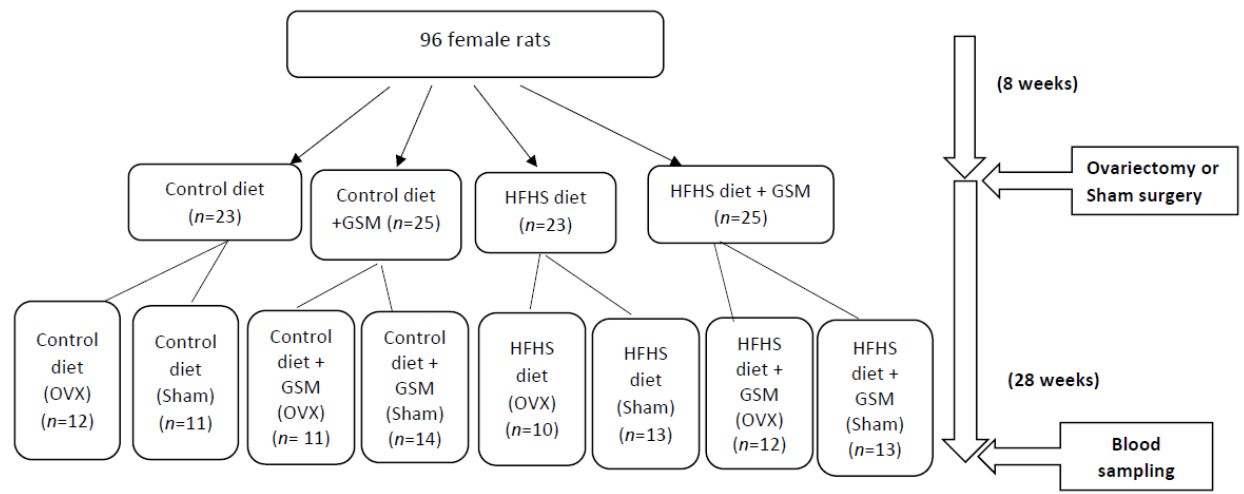
Figure 6. Overview of the study design. Rats were randomized by maternal parentage, bone mineral density, and body weight into groups of control diet (5% sugar, 5% fat, 15% protein from casein), control + GSM diet (5% sugar, 5% fat, 15% protein from 2:1 casein: GSM), HFHS diet (30% sugar, 30% fat, 15% protein from casein), or HFHS + GSM diet (30% sugar, 30% fat, 15% protein from 2:1 casein: GSM) diet. Eight weeks into the study, approximately half of the rats in each group underwent sham surgery (ovaries left intact), while the other half underwent ovariectomy (OVX), after again being randomized by bone mineral density and body weight. Blood samples were collected after 36 weeks.